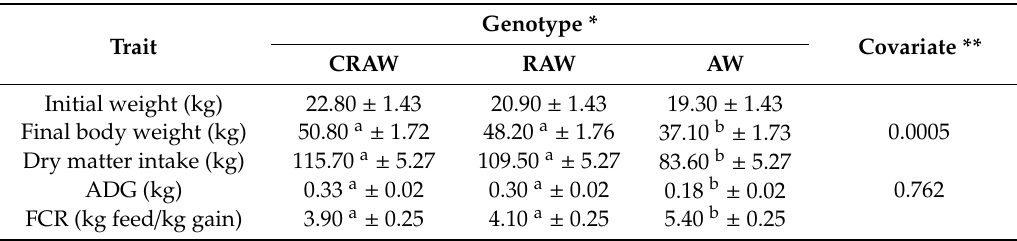
Growth performance of first backcross callipyge Awassi–Rambouillet (CRAW), Rambouillet–Awassi (RAW), and Awassi (AW) lambs.